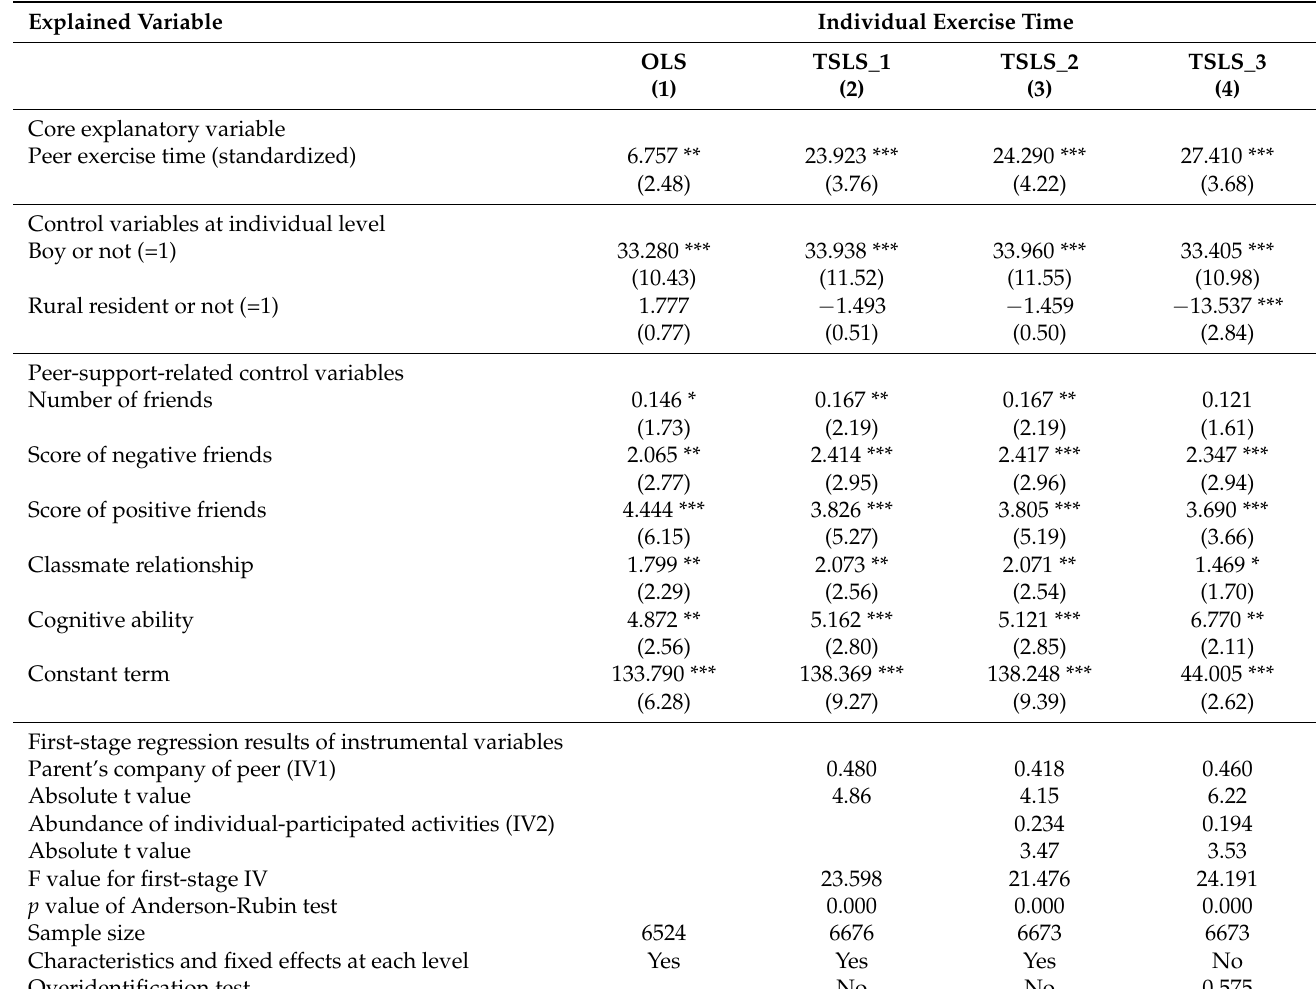
Table 3. Instrumental Variables Regression